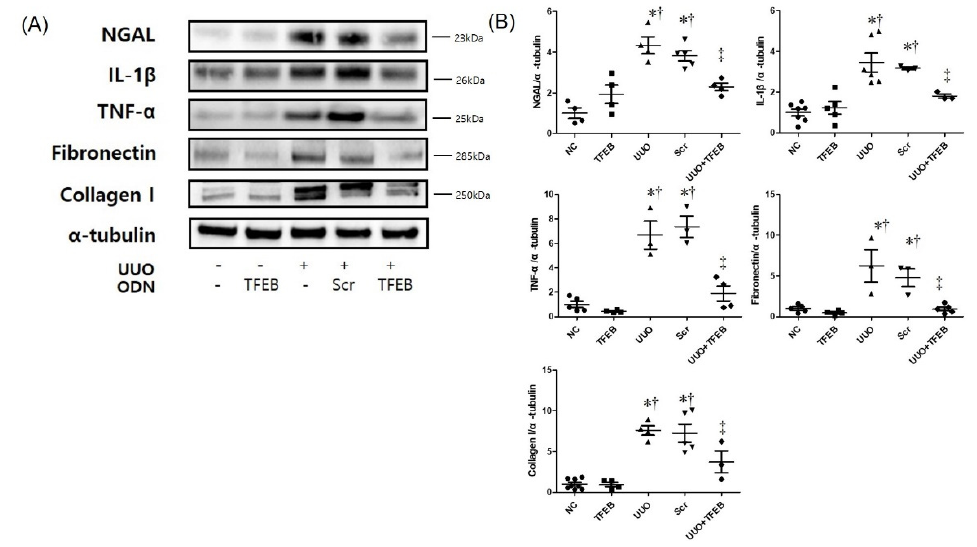
Figure 2. Synthetic TFEB decoy ODN significantly suppressed renal inflammation, fibrosis, and collagen deposition in UUO mice. ( A ) Western blotting showing NGAL, inflammatory cytokines (IL − 1 β , TNF −α ), fibronectin, and collagen I expression in kidney tissue; ( B ) quantification of the protein expression levels of the Western blot images using Image J program. The results are expressed as mean ± SE of three independent experiments. * p < 0.05 vs. the NC group. † p < 0.05 vs. the TFEB group. ‡ p < 0.05 vs. the UUO or Scr group. NC, normal control group; TFEB, TFEB decoy injection in the normal control group; UUO, UUO surgery group; Scr, scramble ODN injection in the UUO surgery group; UUO + TFEB, TFEB decoy ODN injection in the UUO surgery group; UUO, unilateral ureteral obstruction; decoy ODNs, decoy oligonucleotides; TFEB, Transcription factor EB; Scr, scrambled; IL − 1 β , interleukin − 1 β ; tumor necrosis factor −α (TNF −α ).